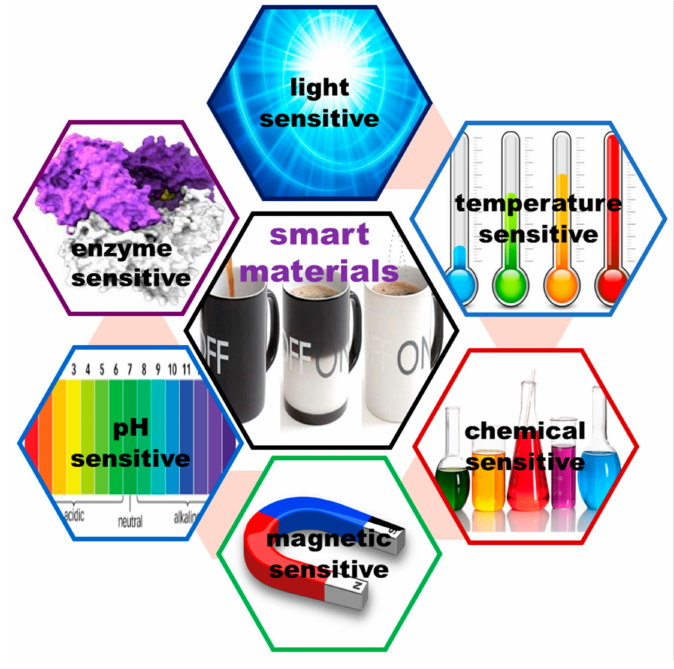
Figure 2. Types of smart